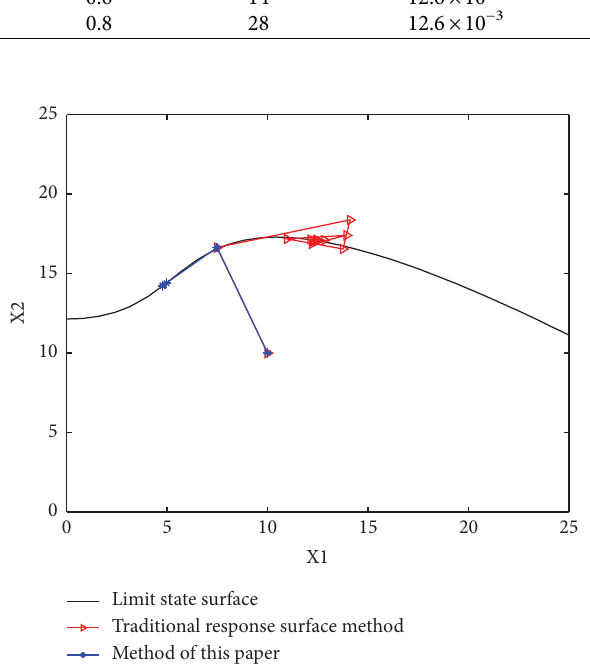
Figure 4: Iterative process of example. Table 2: Calculation results of example